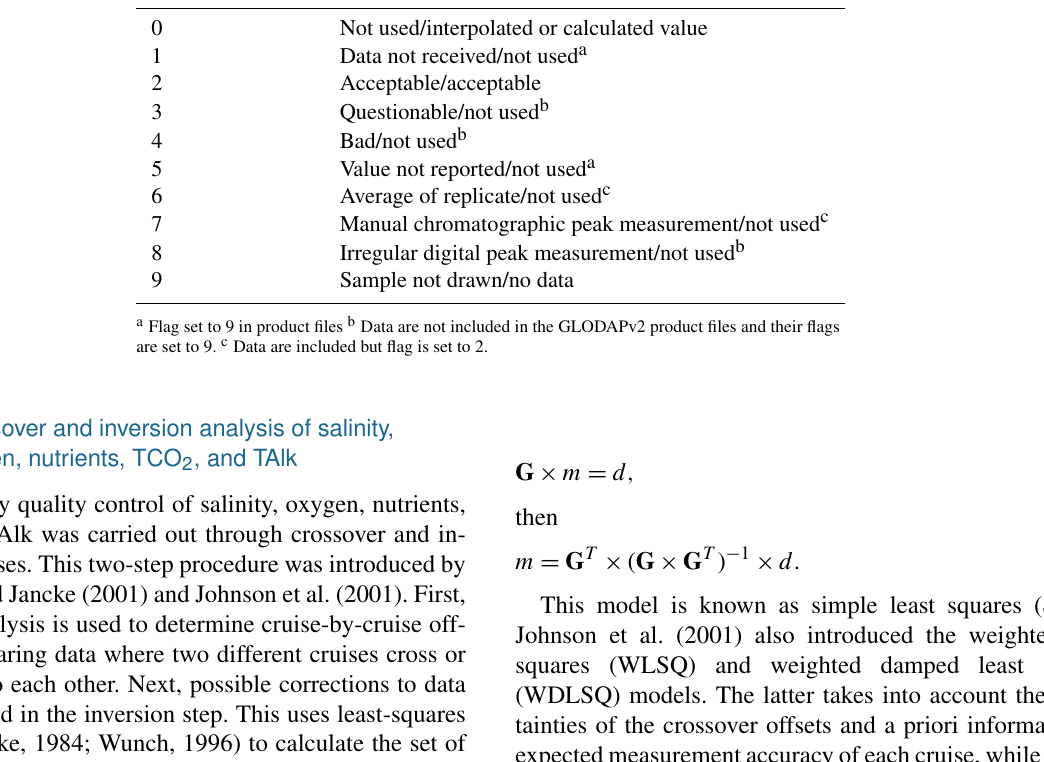
Figure 1. Station locations in (a) GLODAPv1.1, (b) CARINA, and (c) PACIFICA, as well as (d) locations of stations in GLODAPv2 new to data synthesis. Table 1. WOCE flags in GLODAPv2 exchange format original data files and in product files (briefly for exchange files; for full details see http://geo.h2o.ucsd.edu/documentation/policies/Data_Evaluation_reference.pdf). WOCE flag value Interpretation in original data/product